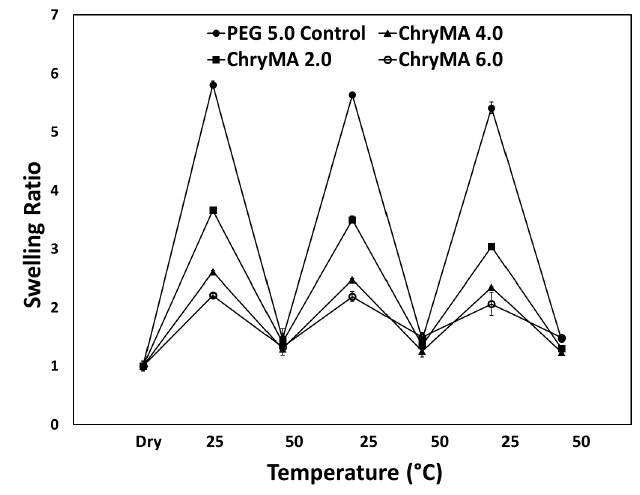
Figure 6. Reversible swelling behavior of NIPAAm- co -ChryMA hydrogels.